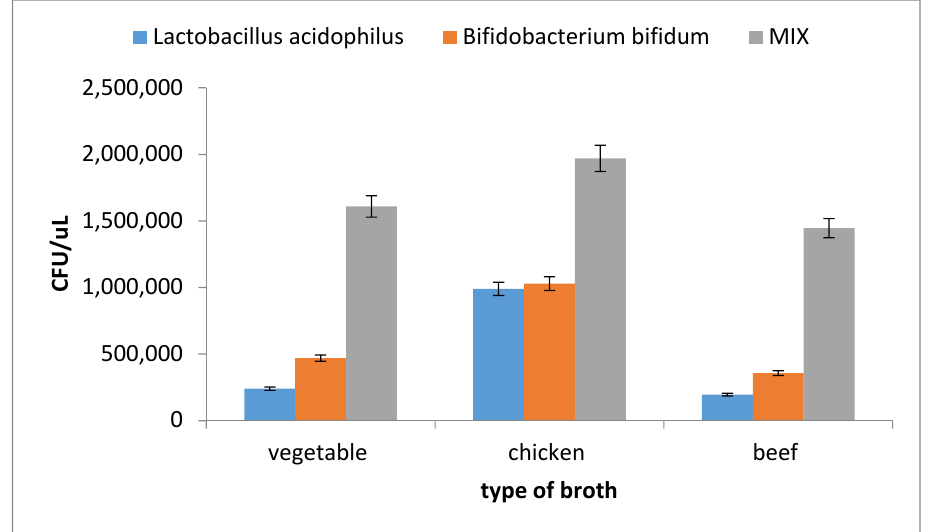
Figure 3. The influence of the type of food extract (broth) and the type of probiotic on the number of viable cells after model digestion.